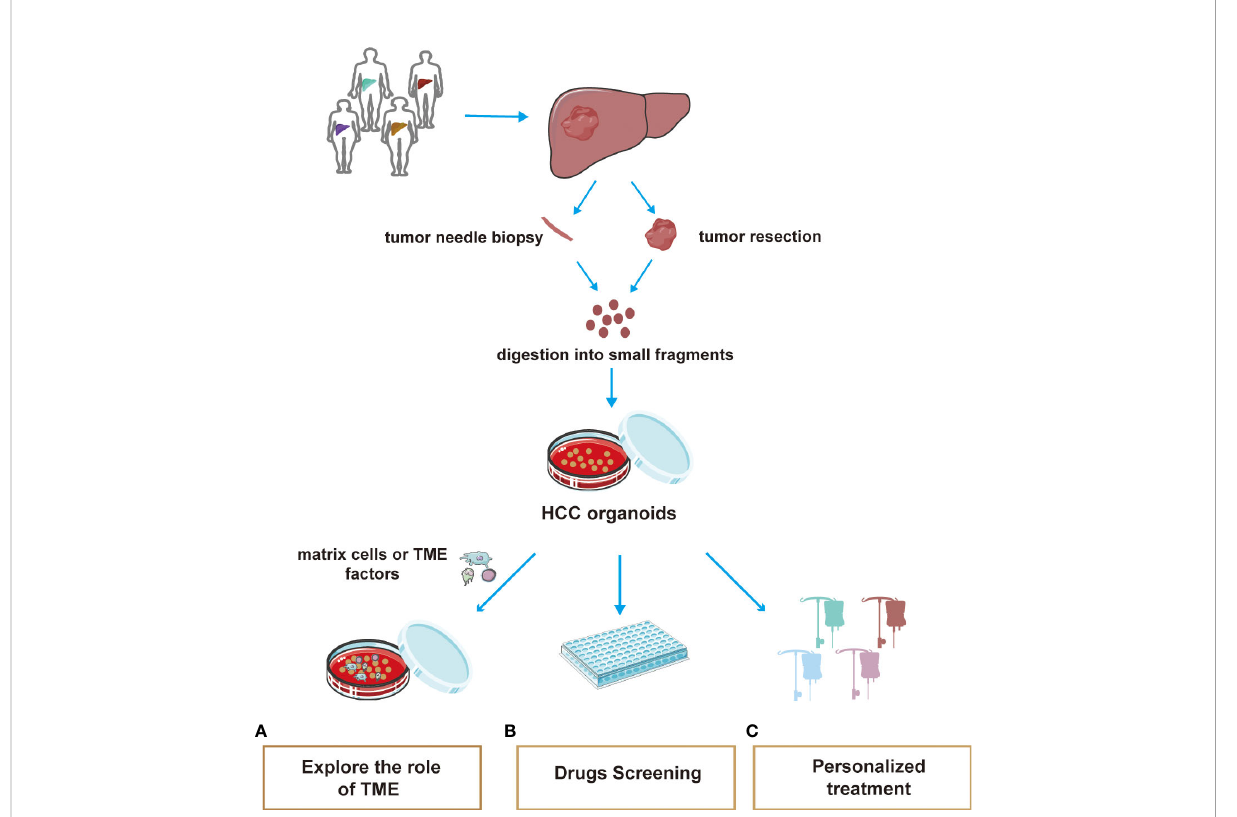
FIGURE 2 A summary of the main applications of HCC organoid. The tissue used in organoid culture of hepatocellular carcinoma is mostly obtained by pathological biopsy and surgical resection. Tissues were cultured for 3D using special media. At present, the application of organoids mainly includes three aspects: (A) Co-culture of HCC organoids with matrix cells or extracellular cytokines helps explore the effects of the TME on HCC progression or therapeutic resistance powerfully. (B) Ef fi cient culture organoids are suitable for high-throughput drug screening (C) Organoid drug screening helps to develop individualized treatment regimen for different